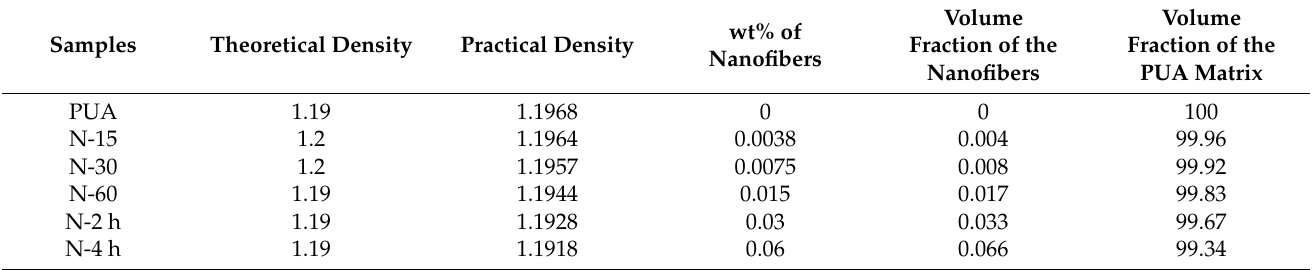
Figure 1. A typical example of the stress–strain curve of ( a ) reference PUA film, ( b ) N-15, ( c ) N-30, ( d ) N-60, ( e ) N-2 h, and ( f ) N-4 h N6/PUA nanocomposite films (from ref. [16] copyright 2021 Wiley-VCH). Table 1. Physical characteristics of the nylon 6 nanofiber-reinforced PUA nanocomposites.